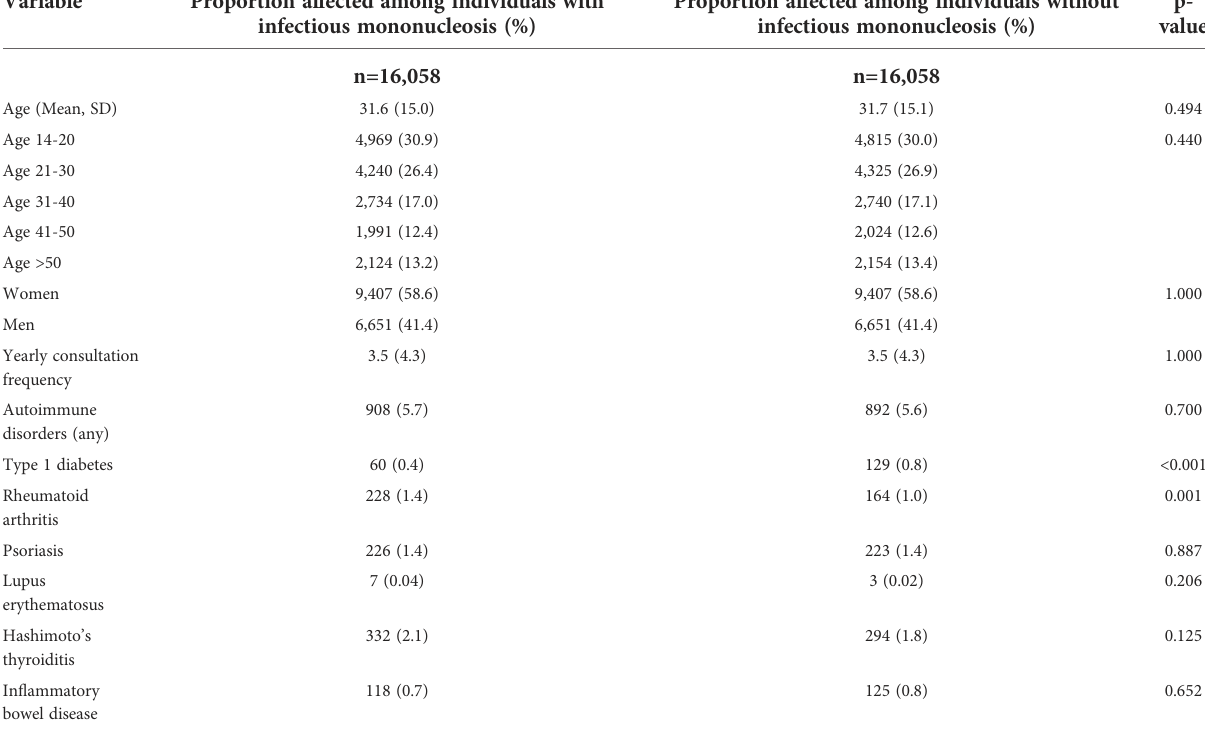
TABLE 1 Basic characteristics of the study sample (after 1:1 matching by sex, age, index year, and yearly consultation frequency). Variable